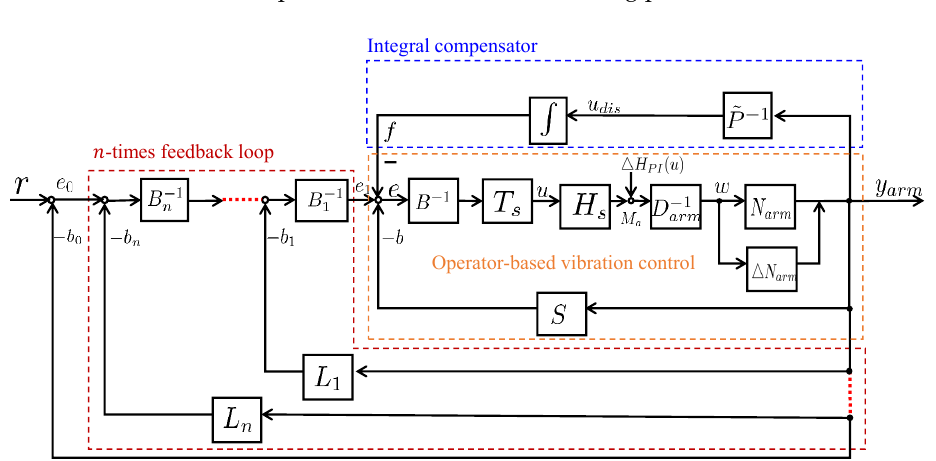
Figure 4. Framework of the proposed interactive actuation vibration control